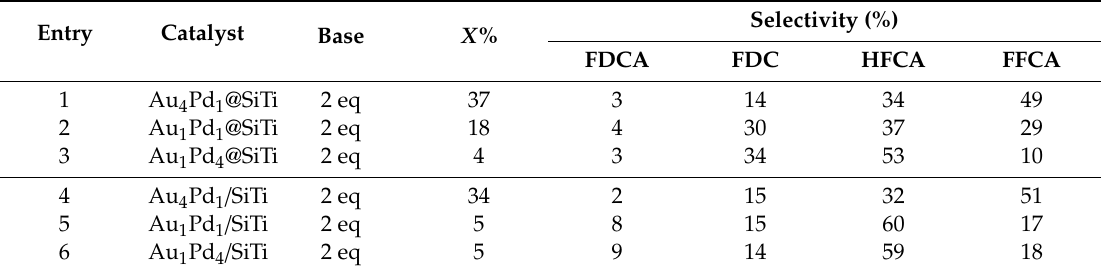
Table 6. Catalytic results obtained in the oxidation of HMF in the presence of the base. Conditions: Aqueous solution of HMF (30 µ mol), substrate / metal = 18 (mol / mol), O 2 (1 bar), 100 ◦ C, 600 rpm, 2 molar equivalents of K 2 CO 3 were added to the reactant solution before catalytic